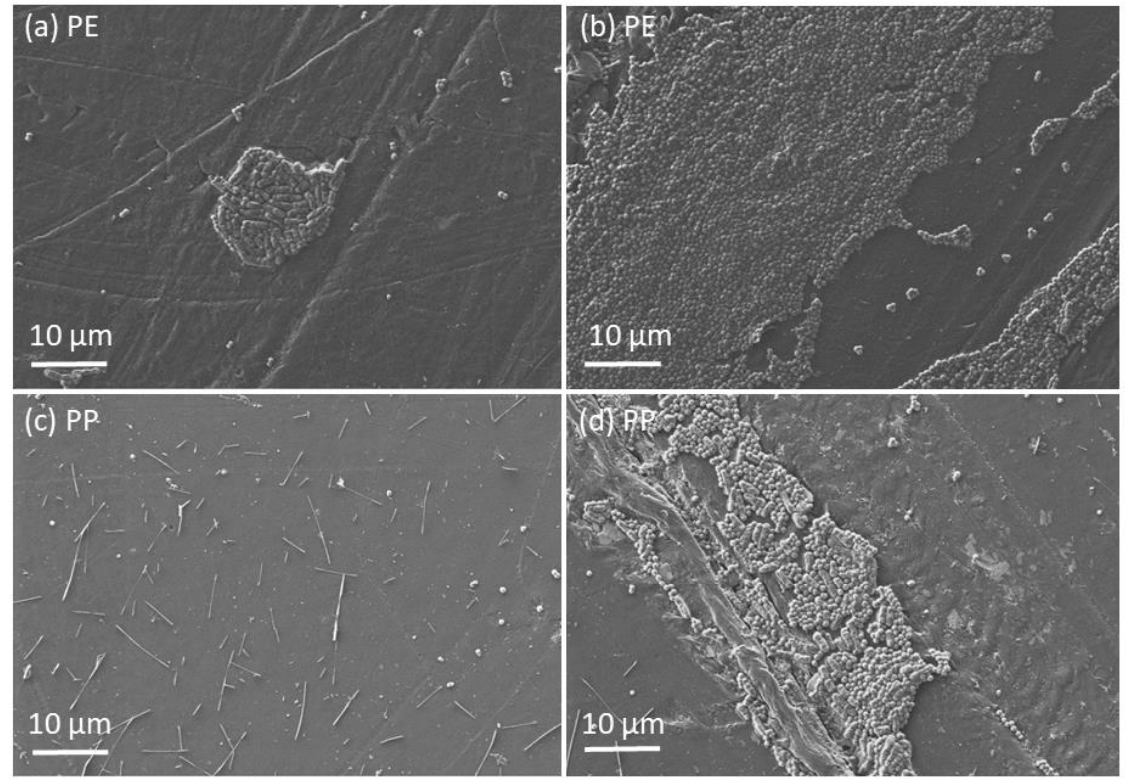
Figure 5. FE-SEM micrographs of the surface of solid polymer samples; bacterial adhesion on ( a ) PE–smooth surface, ( b ) PE–damaged surface, ( c ) PP-smooth surface and ( d ) PP–damaged surface.